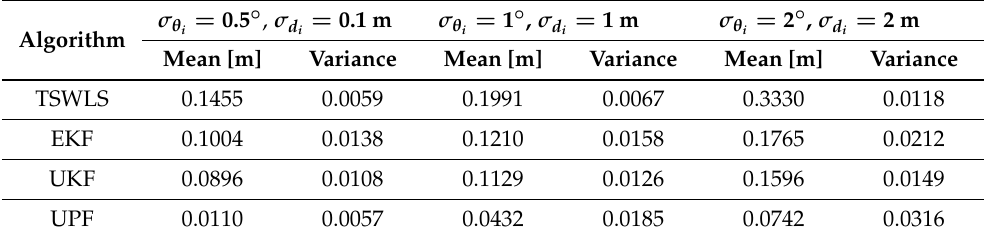
Figure 9. The CDF of RMSE for different algorithms in NLOS scenario ( σ θ Table 2. The statistical parameters of positioning error in NLOS scenarios.